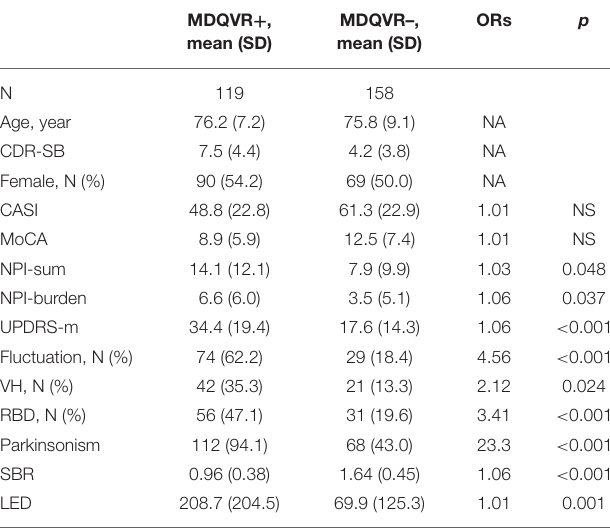
TABLE 3 | Multivariate risk estimates (ORs) for all participants in the positive MDQVR composite scale (MDQVR + ) group compared with the negative (MDQVR–) group adjusted for age, sex, and